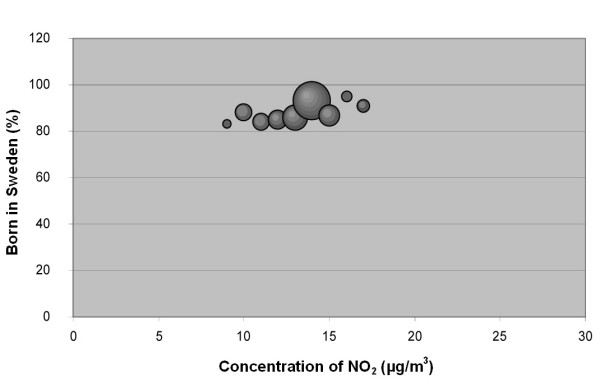
Bubble diagram for Lund; Percentage of population in Lund born in Sweden versus annual mean concentration of NO2 at their real estate. The bubbles are sized according to the weight of the estimate, which depends on the size of the population that the estimate is based on. The weight is thus a measure of the uncertainty in the estimate, and large bubbles represent more certain and influential estimates than small bubbles.